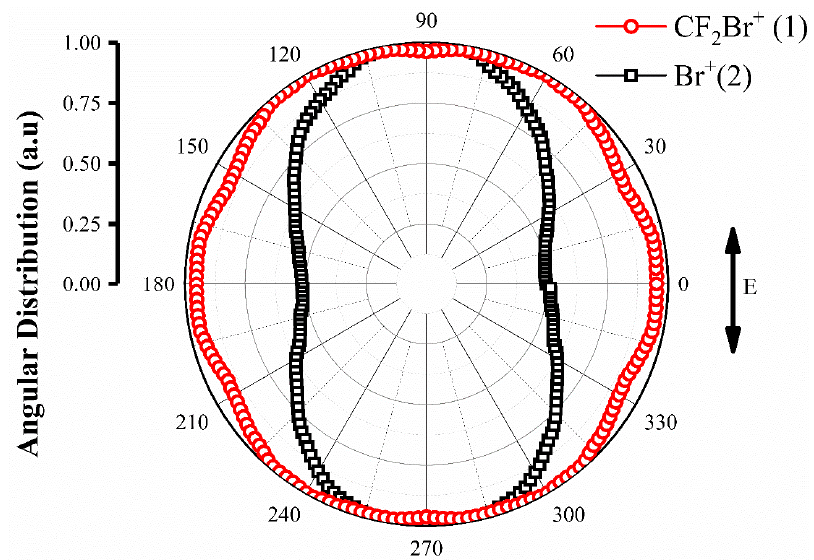
Figure 6. The angular distribution of Br + and CF 2 Br + ions, in which the black double headed arrow represents the laser polarization direction.